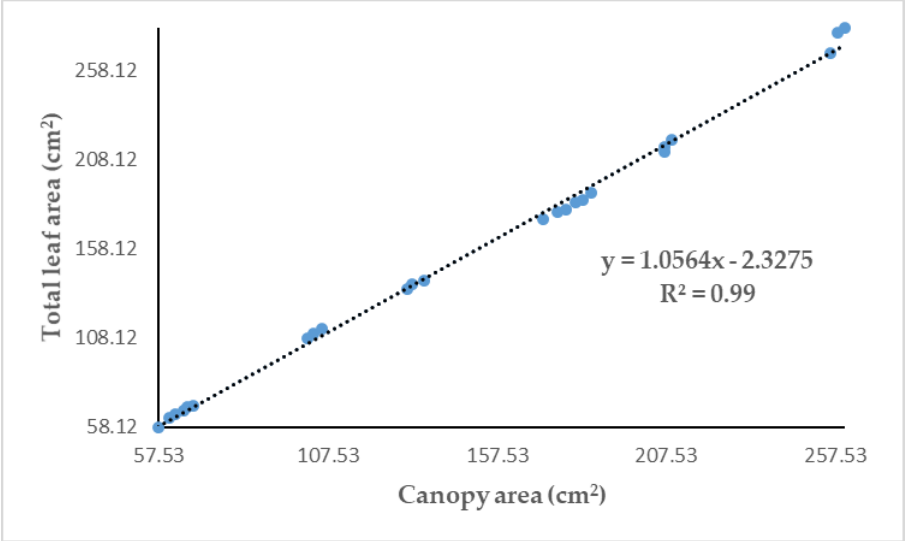
Figure 6. Correlation between canopy area and total leaf area.